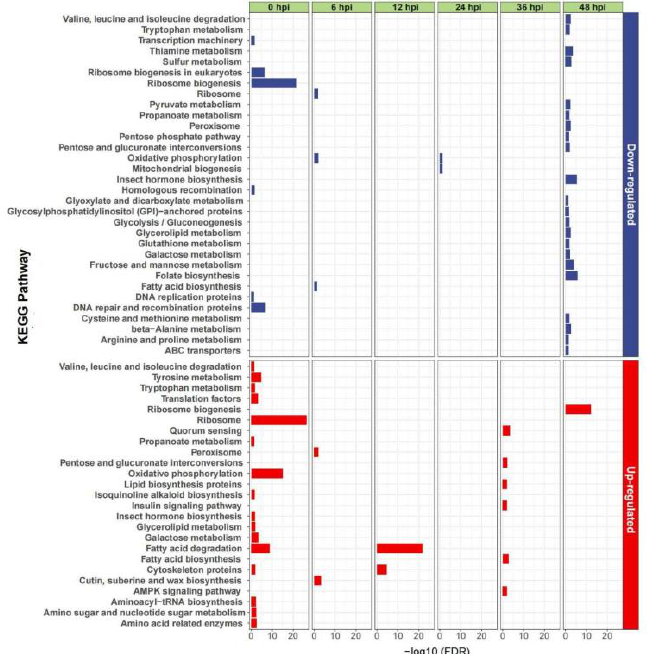
Figure 4. KEGG enrichment-analyses of DEGs among different infected time-points (EcobNPV-QF4 vs EcobNPV-QV). KEGG enrichment-analyses of differentially expressed E. grisescens transcripts were first separated into down-regulated unigenes (top portions) and up-regulated unigenes (bottom portions), and then illustrated in EcobNPV-QF4 vs EcobNPV-QV comparison groups in different time ( p -value < 0.05).